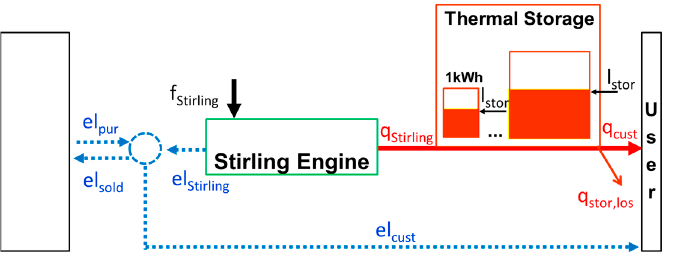
Figure 4. Schematic representation of the system energy fluxes considered in the case study; thermal storage may range from 1 to 10 kWh, out of which 1 kWh is due to the heating system and 0 to 9 kWh the thermal storage tank. From left to right, the short “el” stands for electricity, “pur” for purchased, “f” for fuel, “cust” for customer, “stor” for